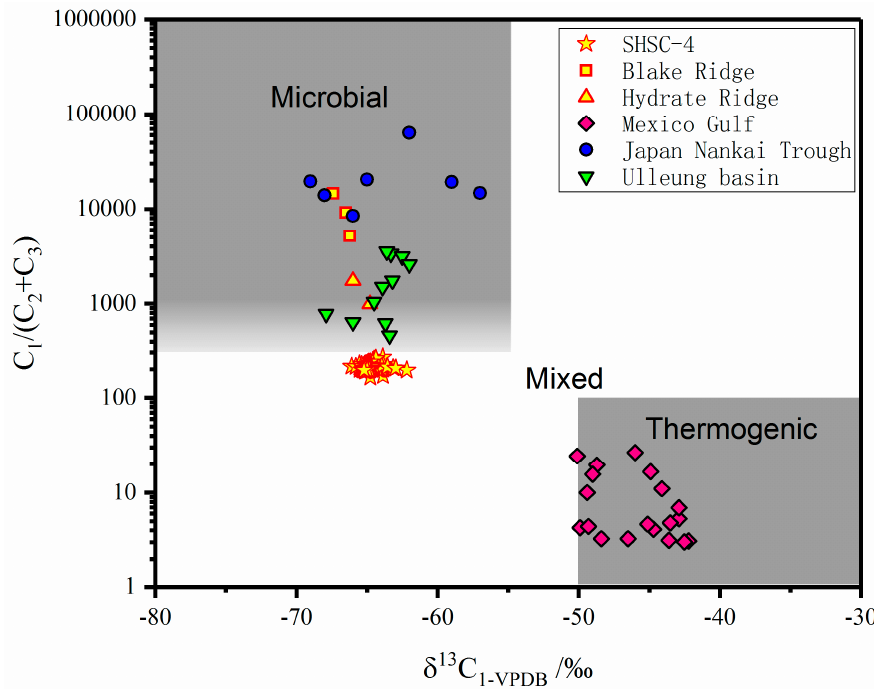
Figure 4. Relationship between C 1 /(C 2 + C 3 ) and δ 13 C-C 1 of hydrocarbon from China’s first offshore gas hydrate production test in SCS (adapted from Whiticar et al. [6]). The data from the Blake Ridge [11], the Hydrate Ridge [7], the Mexico Gulf [12], the Japan Nankai Trough [13], and the Ulleung Basin [14] were plotted for comparison.